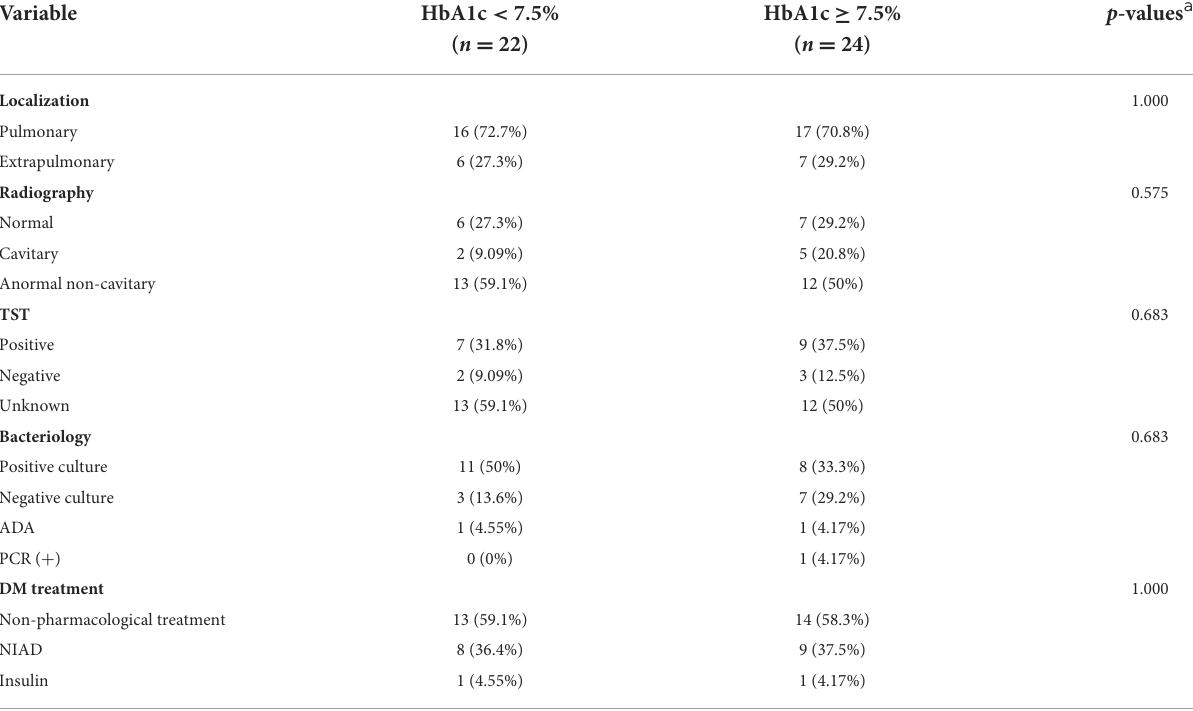
TABLE 2 Characteristics of tuberculosis patients according to basal glycemic control.